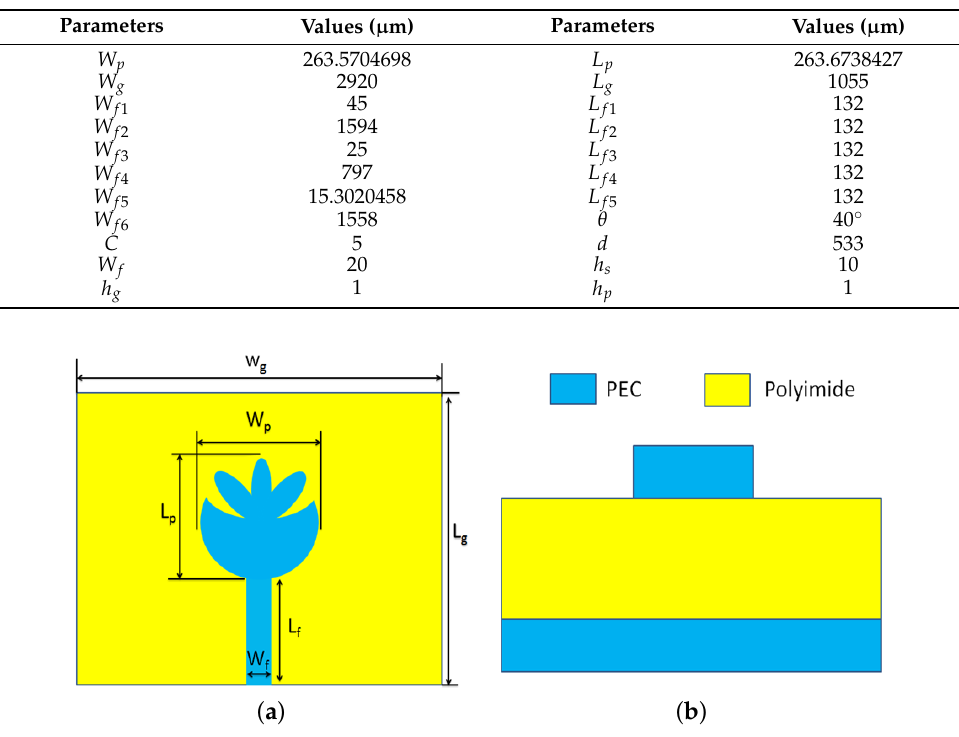
Table 2. List of parameters used in THz antenna array designing.